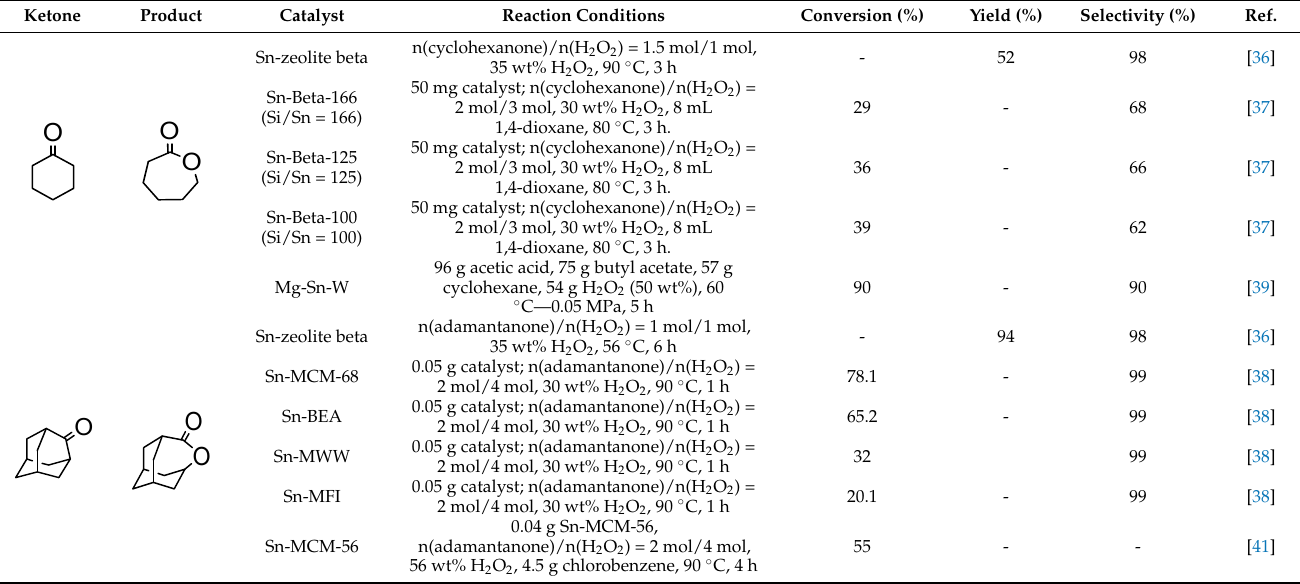
Table 3. Catalytic performances of Sn-containing materials for the oxidation of cyclohexanone and adamantanone.